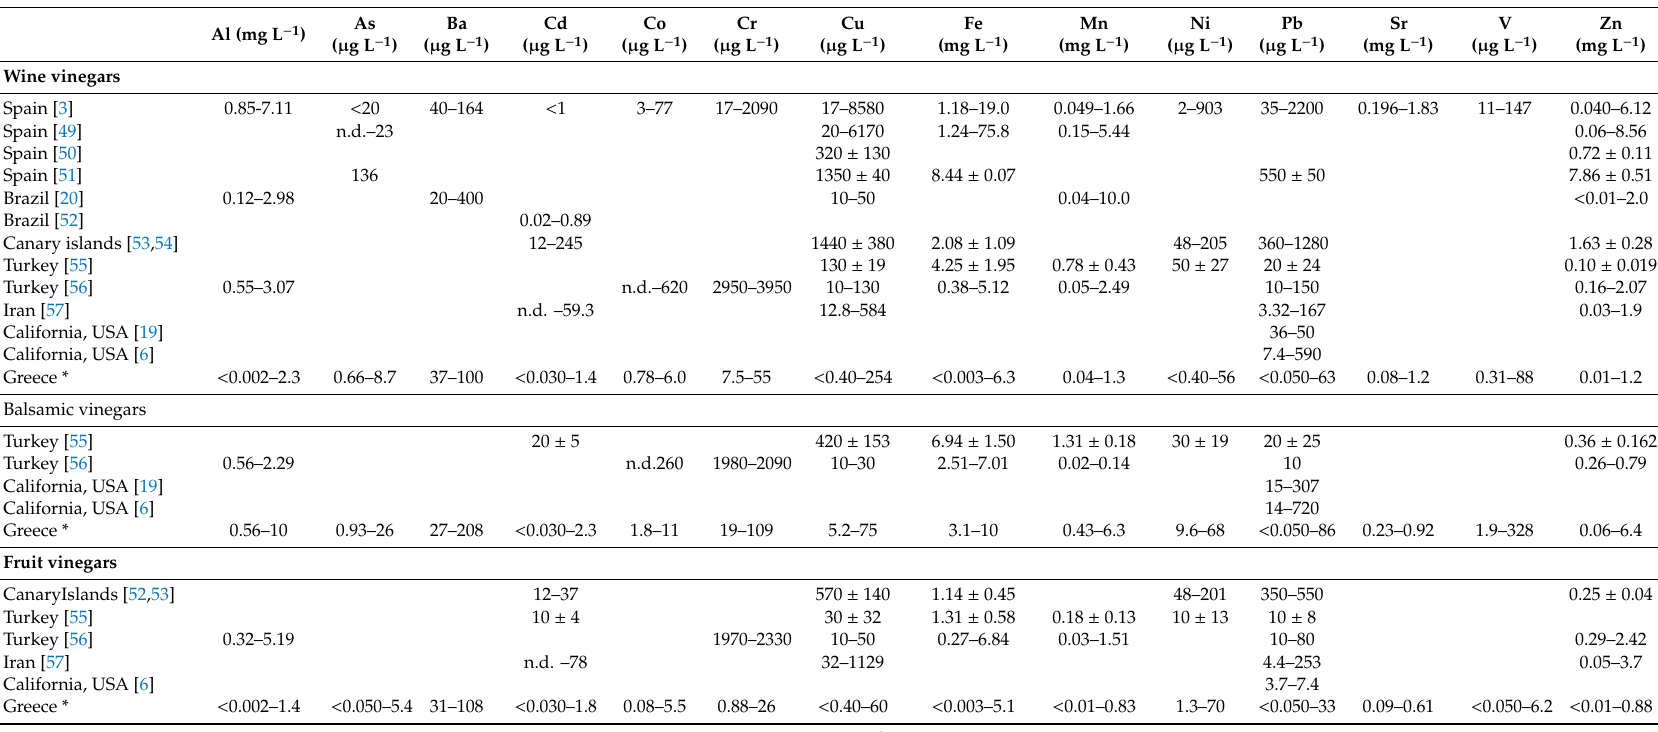
Table 2. Concentrations of trace metals in di ff erent types of vinegars reported in literature. Countries refer to place of